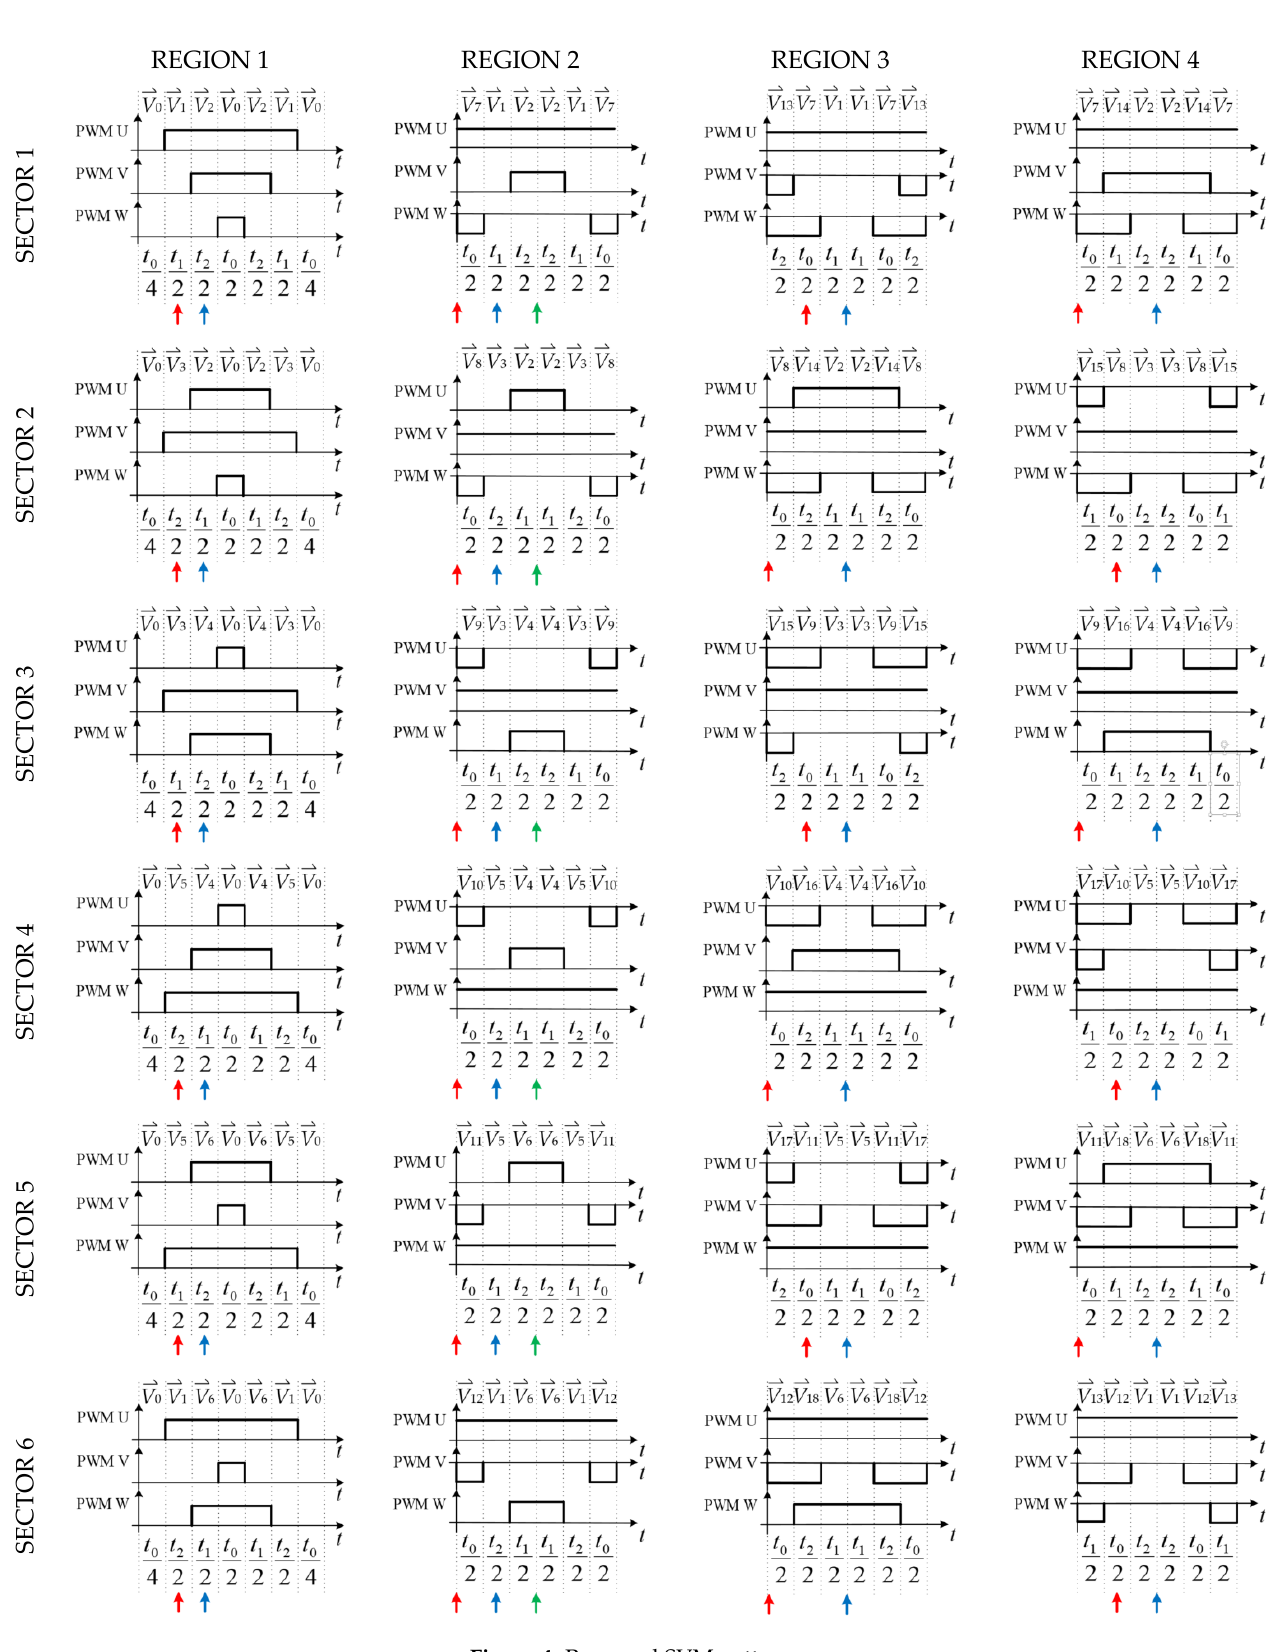
Figure 4. Proposed SVM patterns.